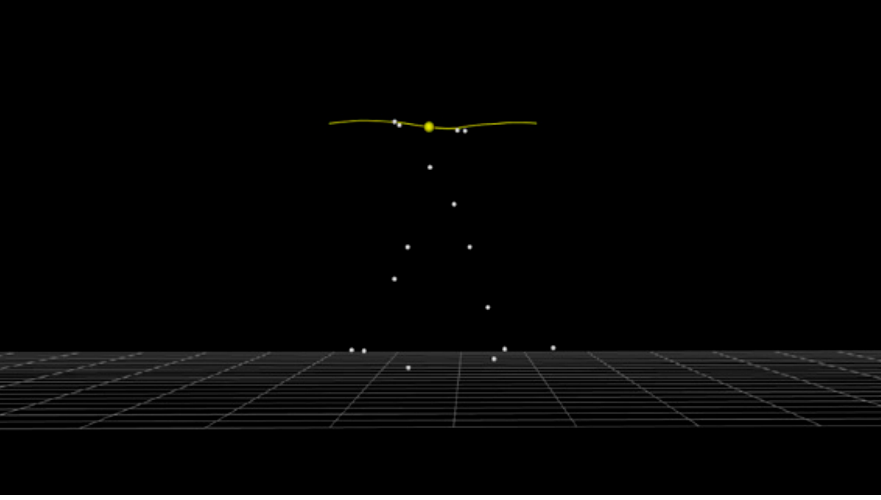
Figure 3. Reflective marker placement according to the Plug-In-Gait lower limbs model.